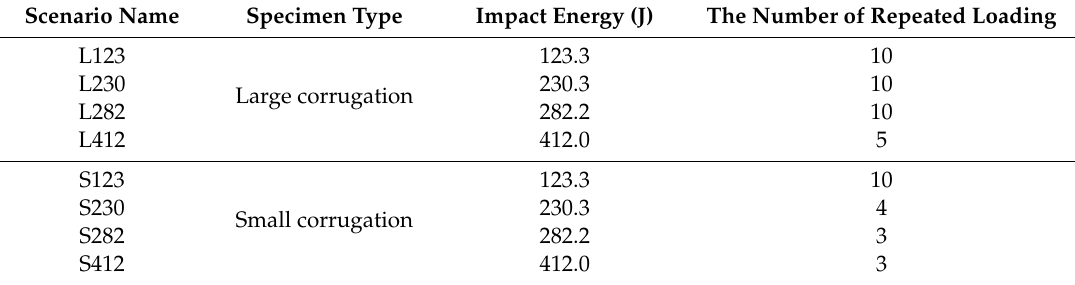
Table 3. Experimental scenario for primary barrier under the repeated impact